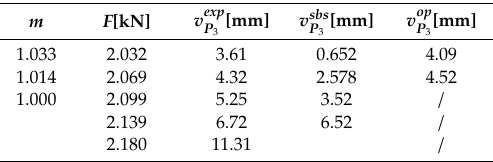
Table 9. Displacement of P 3 from experimental measures, v exp approach, v sbs , and upper bound through optimization programs, v op P 3